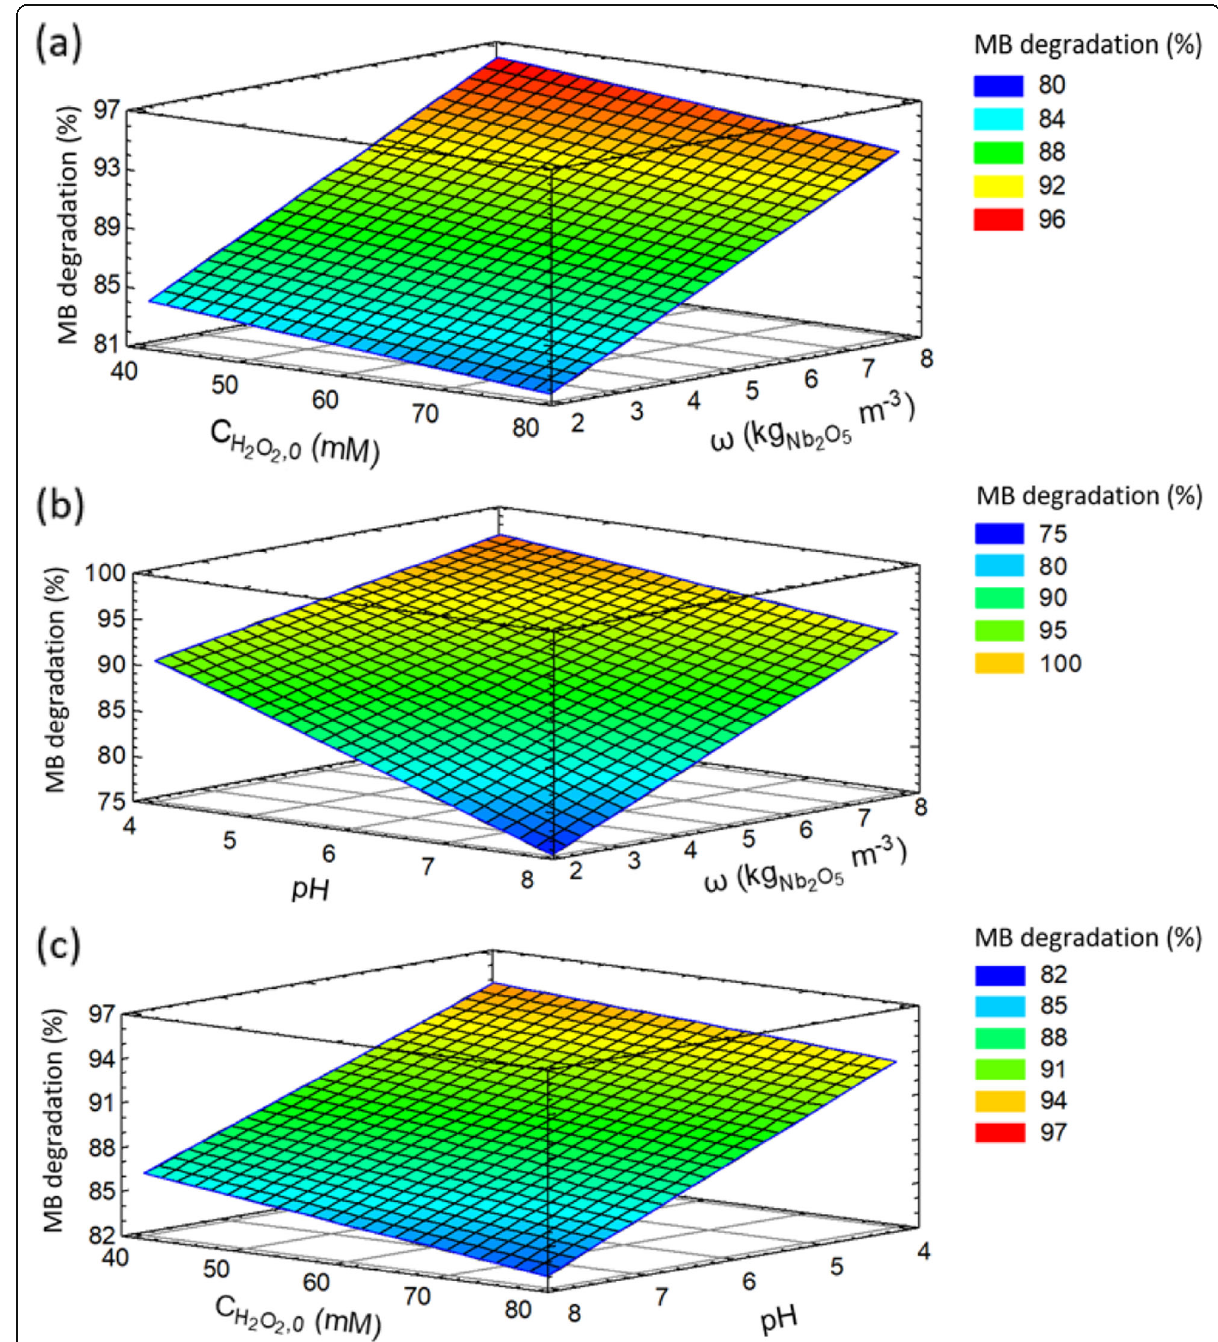
Fig. 5 Response surface for methylene blue degradation using Nb 2 O 5 /Al 2 O 3 /Al catalyst. Ref.: ( a ) pH=6; ( b ) C H